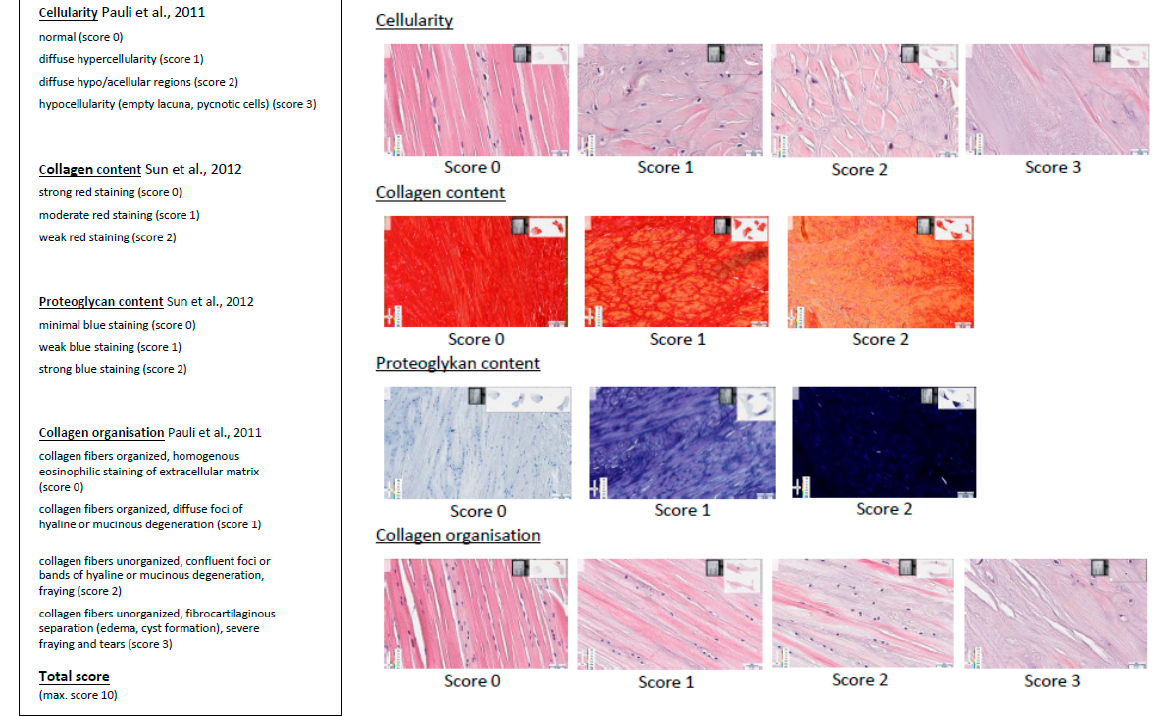
Figure 2. Modified histological scoring system according to